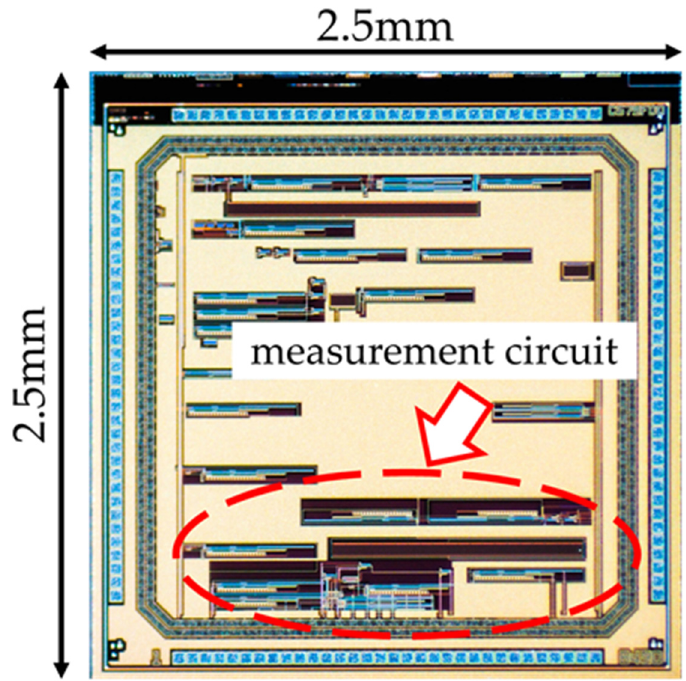
Figure 8. Designed chip (optical microscopy image).